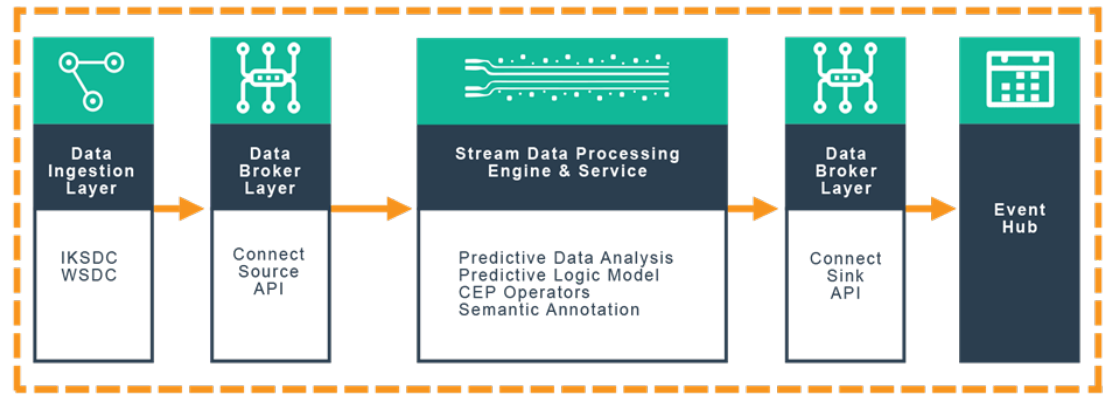
Figure 4. The high-level view of ESTemd distributed middleware framework for real-time analysis of environmental management and monitoring